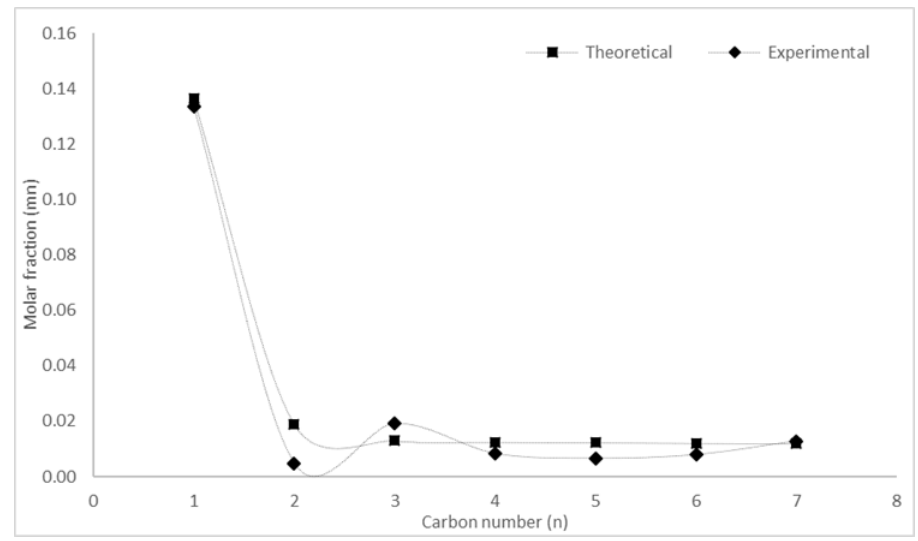
Figure 7. Comparison of measured product distribution with that predicted by the fitted dual α model.